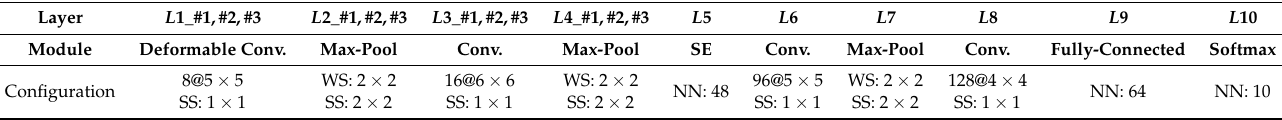
Table 2. FEF-Net instance configurations. Convolutional layers are represented as Conv. and their hyper-parameters denote as (number of feature maps)@(kernel size in convolution). “ La _# b ” represents the b th branch of a th layer. “WS,” “SS,” and “NN” denote window size, stride size, and number of neurons in network, respectively.